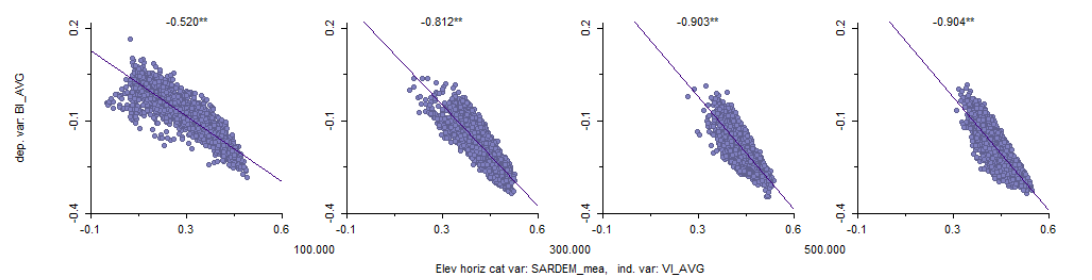
Figure 10. Scatter plot of NDBI vs. NDVI, categorized by elevation.